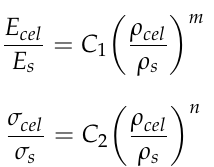
Strain Figure 2. Compression stress–strain curve of the D structure. The tensile specimens were prepared with the same printing process parameters as the D structure, and the elastic modulus and tensile mechanical properties of the specimen were obtained. The shape and size of the tensile specimen are shown in Figure 3. The tensile mechanical properties of the bulk material are listed in Table 2. Figure 3. Shape and size of tensile specimen.